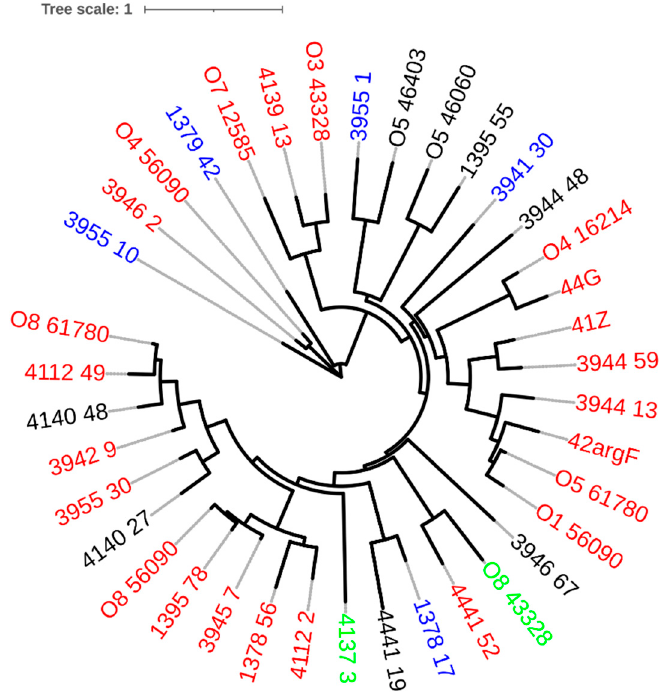
Figure 1. Phylogenetic tree of prophage genomic sequences, using the Jukes–Cantor substitution model and no bootstrapping/likelihood as branch support method in PHYML 3.3.20180621 (Geneious version 2021.1.1). The tree was visualized with iTOL v6 [30]. Prophages found in P. aeruginosa genomes retrieved from PATRIC start with capital letter O. Each tree leaf is color-coded according to the predicted phage family: red— Siphoviridae; blue— Myoviride ; green— Podoviridae .